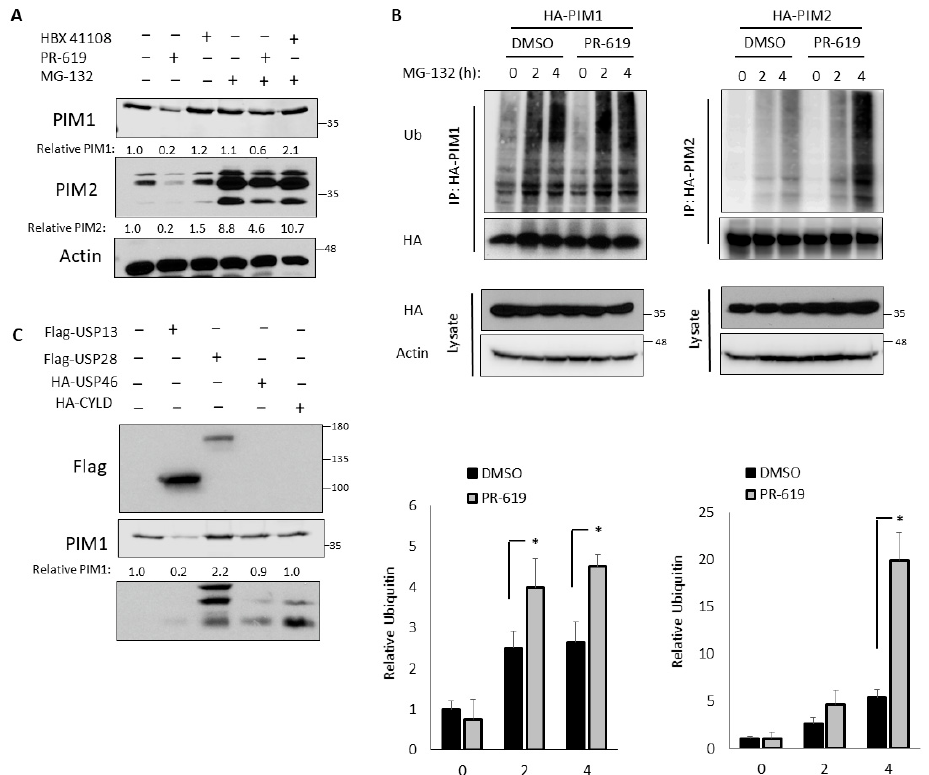
Figure 2. PIM kinase ubiquitination and stability is controlled by deubiquitination by ubiquitin- specific protease 28 (USP28). ( A ) PC3-LN4 cells transfected with HA-PIM1 were treated with PR619, HBX 41108, MG-132, or a combination for 6 h. Lysates were harvested for western blotting. ( B ) 293T cells were transfected with HA-PIM1 or HA-PIM2 and pretreated with vehicle or PR619 for 30 min. Then, cells were treated with MG-132 for 2 or 4 h to block protein degradation. HA-PIM1/2 were immunoprecipitated, and immunoprecipitated and input lysates were used for western blotting. Below, quantification of relative ubiquitin density. ( C ) PC3-LN4 cells were co-transfected with HA-PIM1 and a control vector, Flag-USP13, Flag-USP28, HA-USP28, or HA-CYLD. Lysates were harvested for western blotting approximately 16 h later. * p <